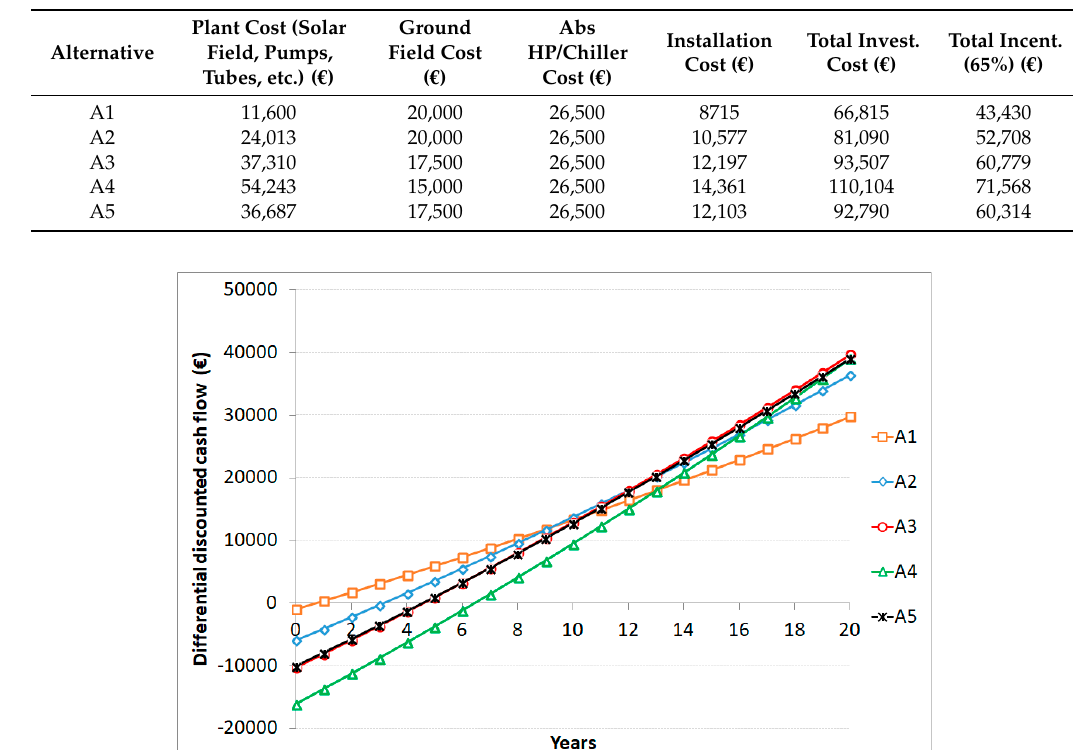
Table 8. Investment cost of the plant, and the “conto termico 2.0” incentive.